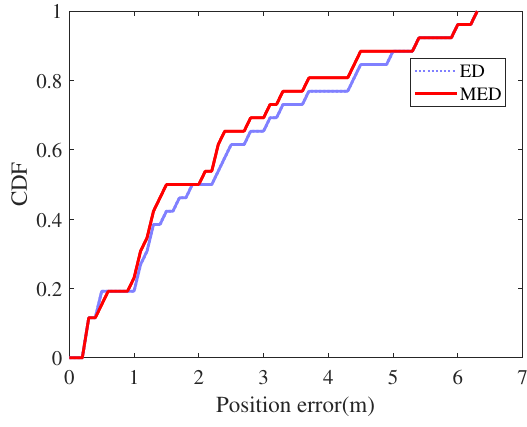
Figure 9. CDF of errors.